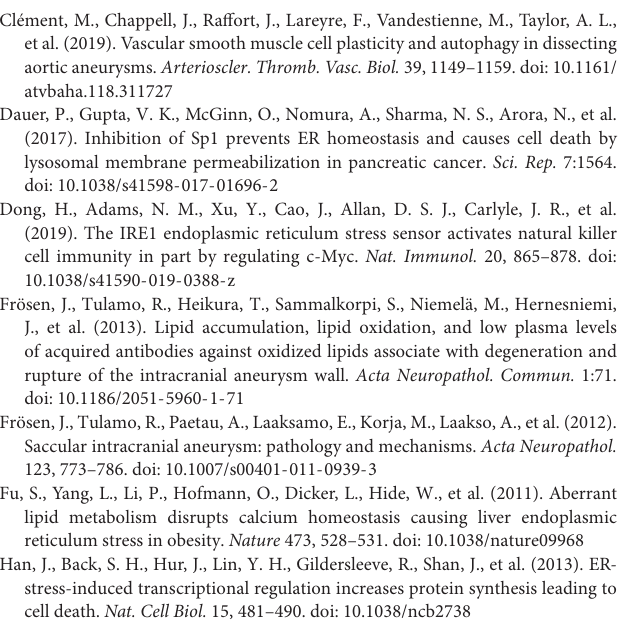
Supplementary Figure 1 | Correlation analysis among ERS, metabolism, and autophagy in both training and validating cohorts. Autophagy (A) and metabolism (B) were positively associated with ERS, separately. Supplementary Figure 2 | Co-expression analysis identifying ERS-related VSMC phenotype genes in the validating cohort. (A) A scale-free network construction (power threshold β = 4). (B) Gene dendrogram generating gene modules. (C,D) Correlation analysis between modules and pathophysiological traits. IA occurrence, VSMC synthesis, and ERS had the same two highest correlation modules (MEbrown and MEpink). Supplementary Figure 3 | Correlation analysis between ERS and nearby genes of regulatory regions in both training and validating cohorts. (A) The expression level of ERS signature genes. IA lesions had higher expression of FKBP14, TOR1A, EDEM1, BAX, CALR, SEC61B, and lower expression of STUB1 and ADD1. (B) Venn diagrams of differential expressed genes (DEGs) and nearby genes. Six nearby DEGs of regulatory regions were gained. (C) Correlation analysis between ERS signature genes and nearby genes. KCTD15 had the most significant associations with ERS. Supplementary Table 1 | TF intersection between ERS signature genes and regulatory regions. Supplementary Table 2 | Identified 9 small molecular drugs by